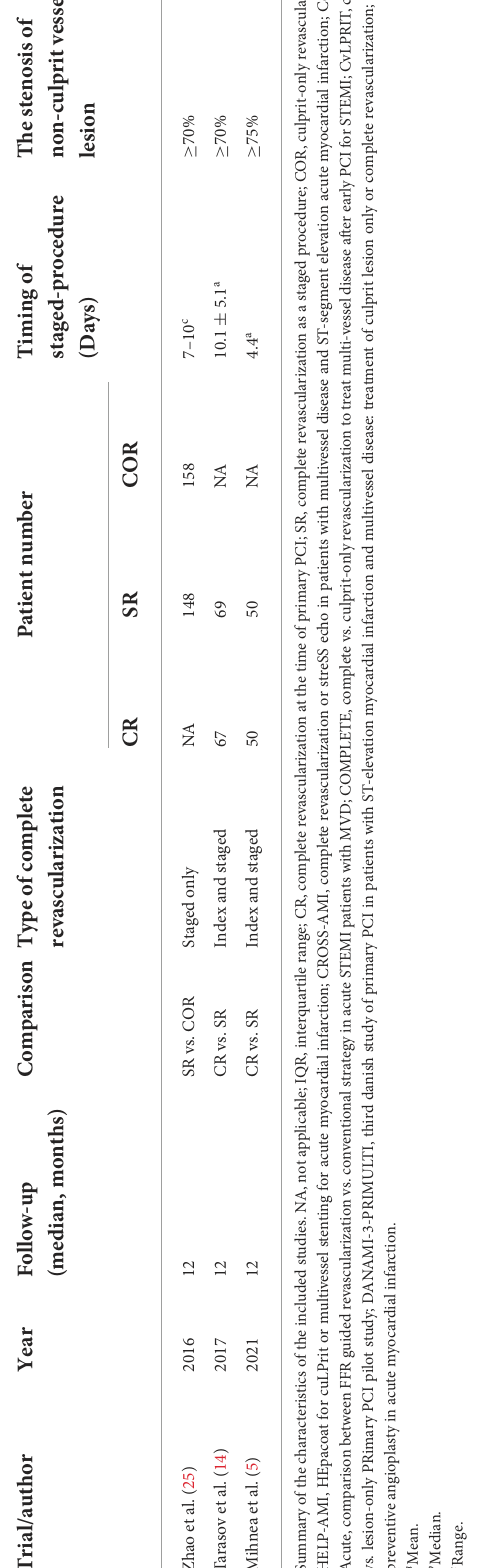
0.87–2.26; p = 0.163; I 2 = 0.0%; Figure 4). Meta-regression analysis showed that follow-up months was not a source of heterogeneity in any results (Supplementary Figure 2). There was no publication bias for any of the outcomes based on Egger’s test (Supplementary Table 4). The outcomes of the pairwise meta-analysis were summarized in Table 2, and the RR value and its 95% CI of each outcome are summarized in Supplementary Figure